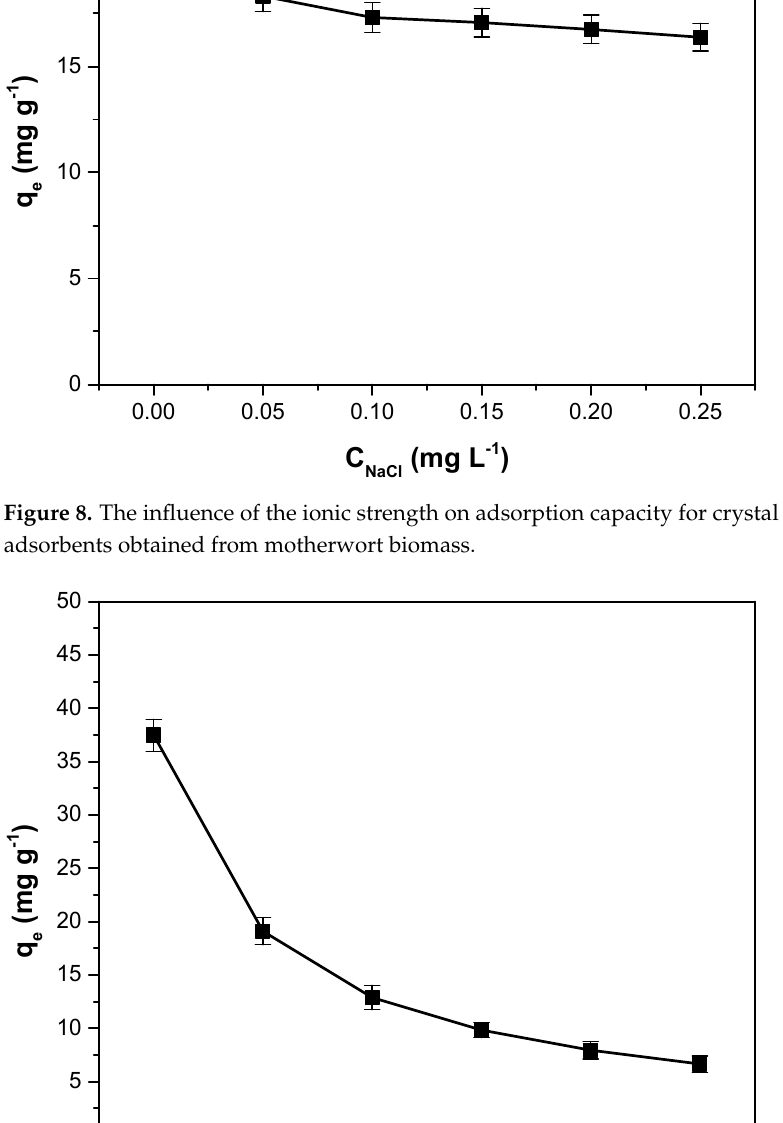
Table 5. Controllable factors and their levels, used in the Taguchi design.